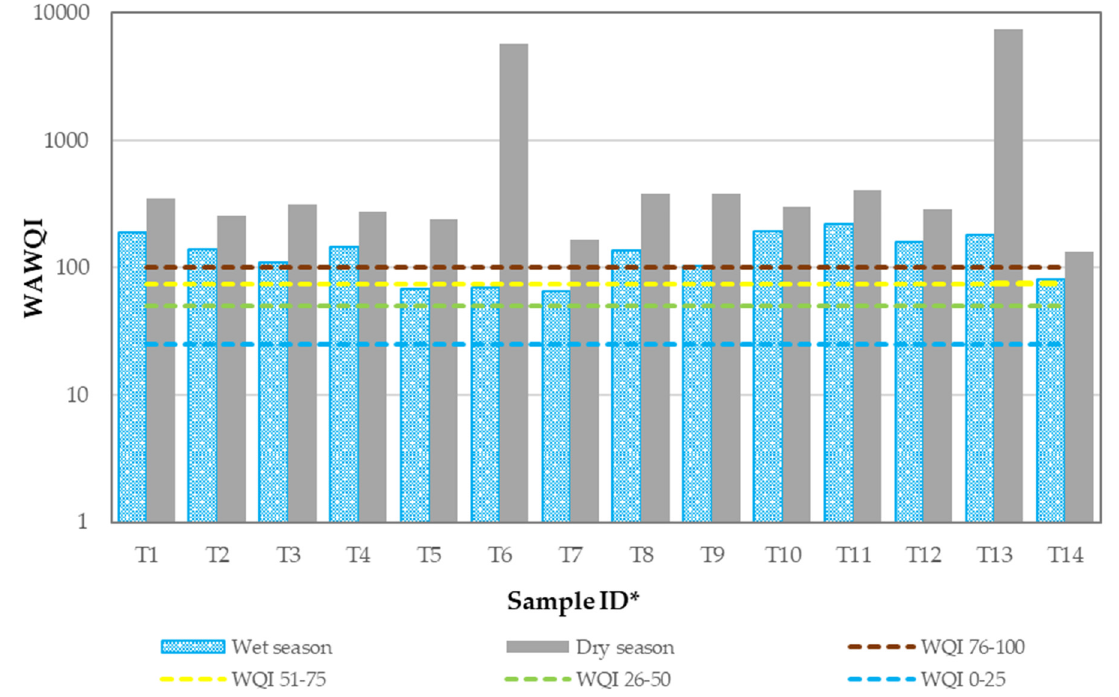
Figure 10. WAWQI at the MXAC by season in 2016. * Sample ID is mentioned in Table 2 with specific location